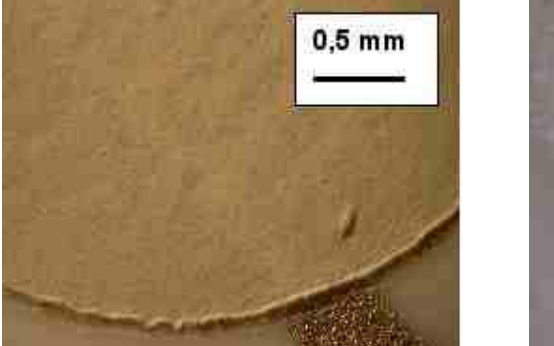
(left) and ZrO layer 3 2